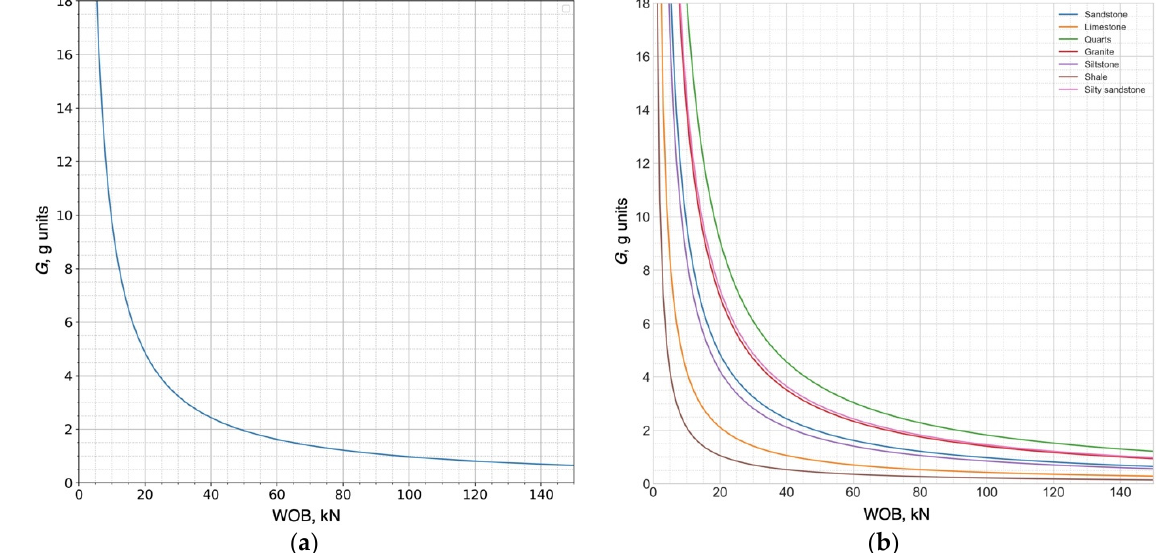
Figure 13. Nomograms: ( a )—WOB–G relation; ( b )—axial and lateral shocks–rate of rotation relation from the cutting depth of sandstone.